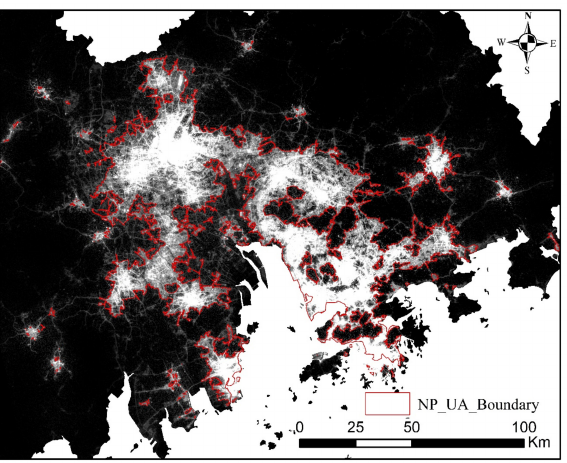
Figure 10. Urban agglomeration boundaries delineated by NTL_POI.